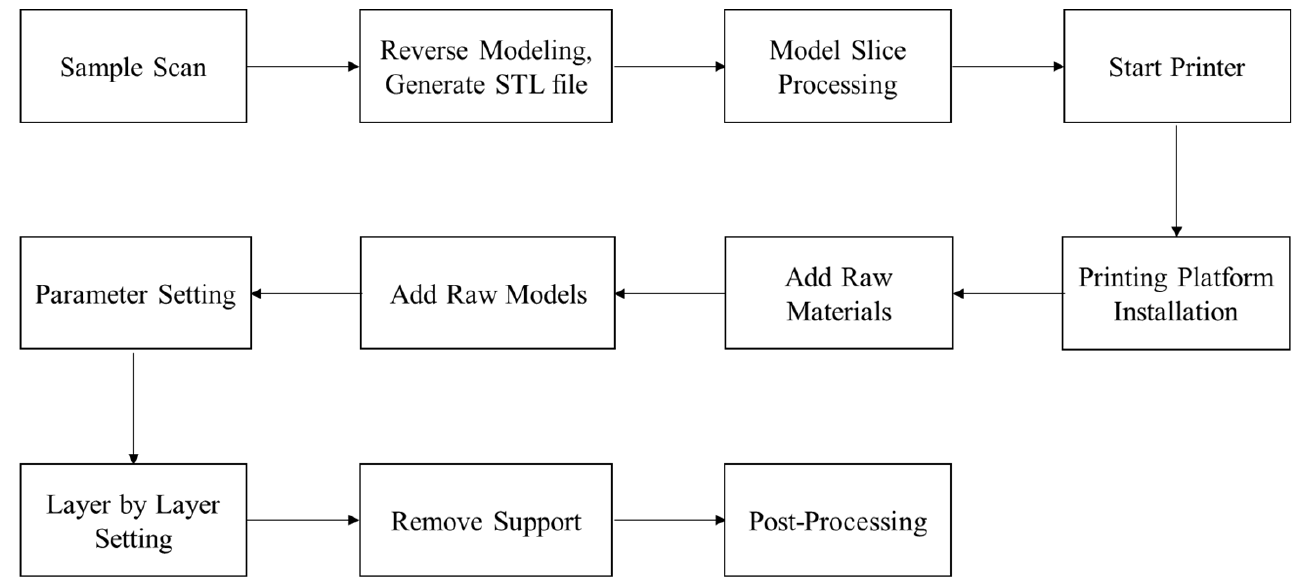
Figure 4. Flow-chart of 3D printing procedure.